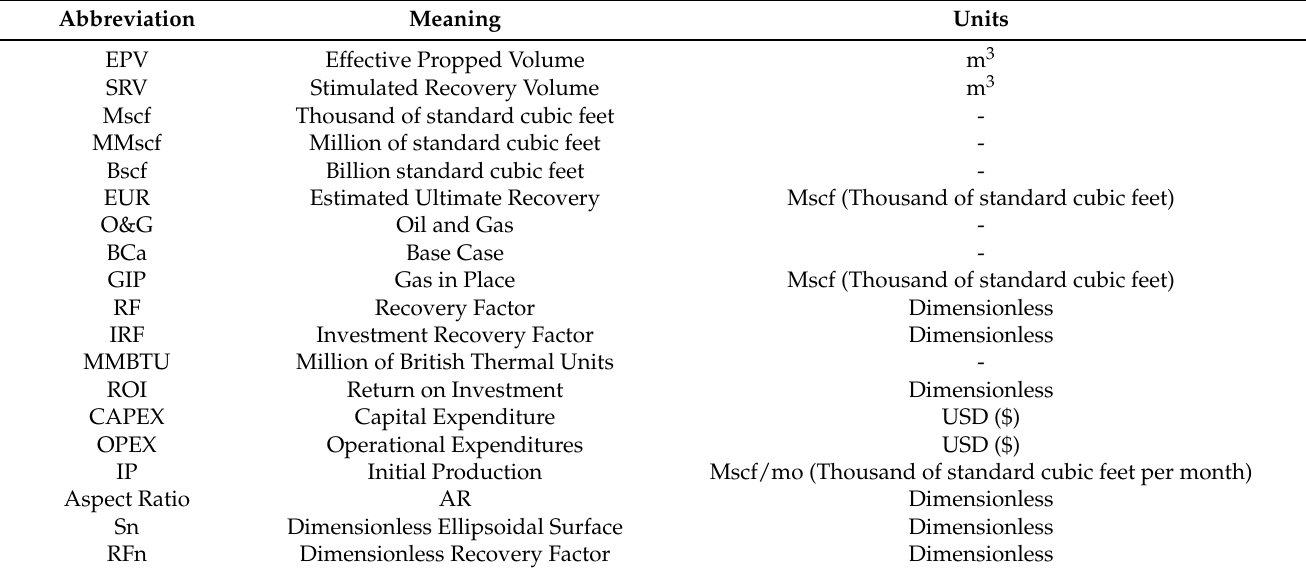
Table 1. Abbreviations, meaning and